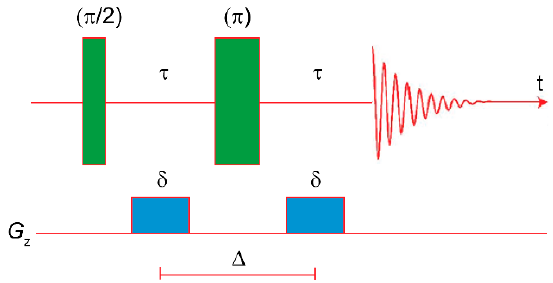
Figure 3. Pulse sequence for the pulsed-field gradient spin echo (PGSE) experiment (basic version).